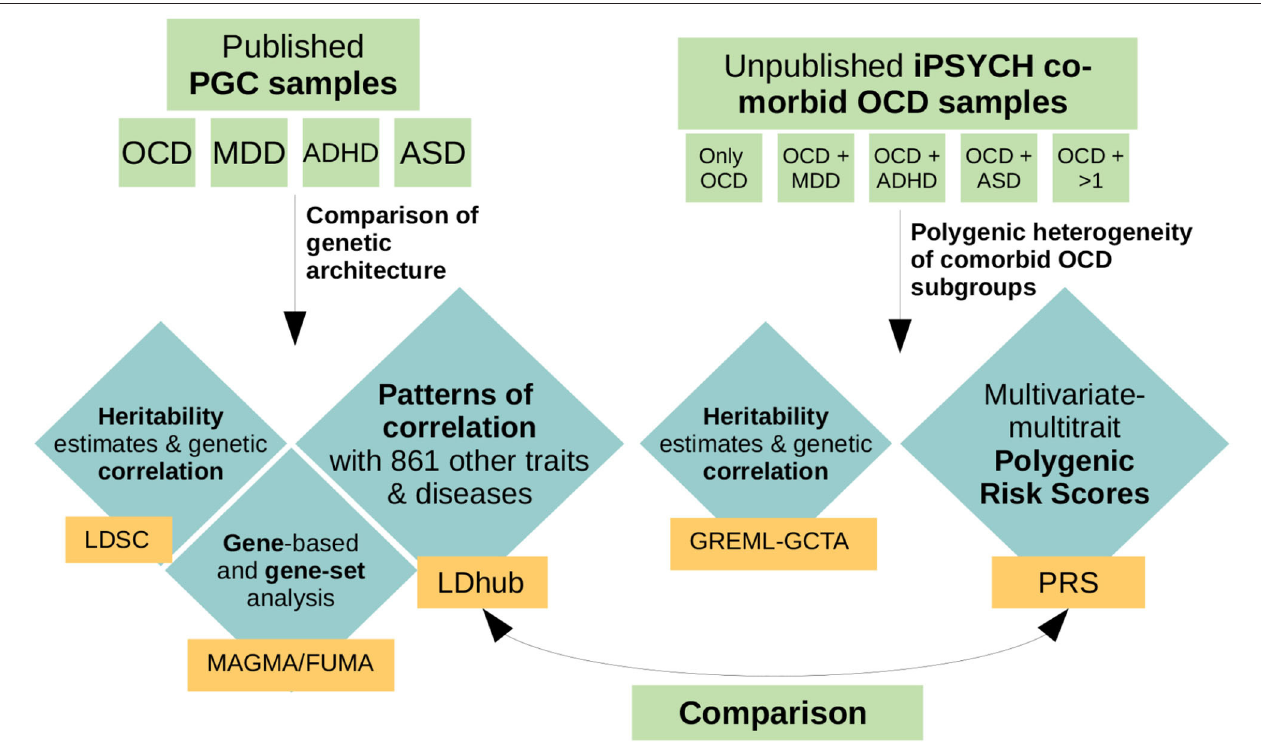
FIGURE 1 | Schematic overview of performed analyses. For the first part of the analyses, we used previously published, publicly available GWAS summary statistics of obsessive-compulsive disorder (OCD), major depressive disorder (MDD), attention-deficit hyperactivity disorder (ADHD), and autism spectrum disorder (ASD) from the psychiatric genetics consortium (PGC). We used those datasets to compare the polygenic architecture of OCD, MDD, ADHD, and ASD by examining heritability estimates and genetic correlations (LDSC), their overlap in associated genes and gene-sets (MAGMA/FUMA), and compared each disorders genetic correlation pattern with 861 other traits and diseases (LDhub). For the second part of the analyses we used an independent and previously unpublished dataset from iPSYCH, comprising 2,938 individuals with a diagnosis of OCD, of which 366 presented only a diagnosis of OCD, 1,052 a diagnosis of OCD and MDD, 443 a diagnosis of OCD and ADHD, 388 a diagnosis of OCD and ASD, and 429 a diagnosis of OCD and more than one comorbidity. For these sub-groups we assessed heritability and genetic correlation estimates (GREML-GCTA) and examined the patterns of association of each comorbid OCD subgroup with eight different polygenic risk scores (PRS) based on a variety of phenotypes. In a last step we compared the patterns that evolved in the genetic correlation analysis in step one with the patterns of association that resulted from the PRS analyses of the OCD comorbid subgroups in step